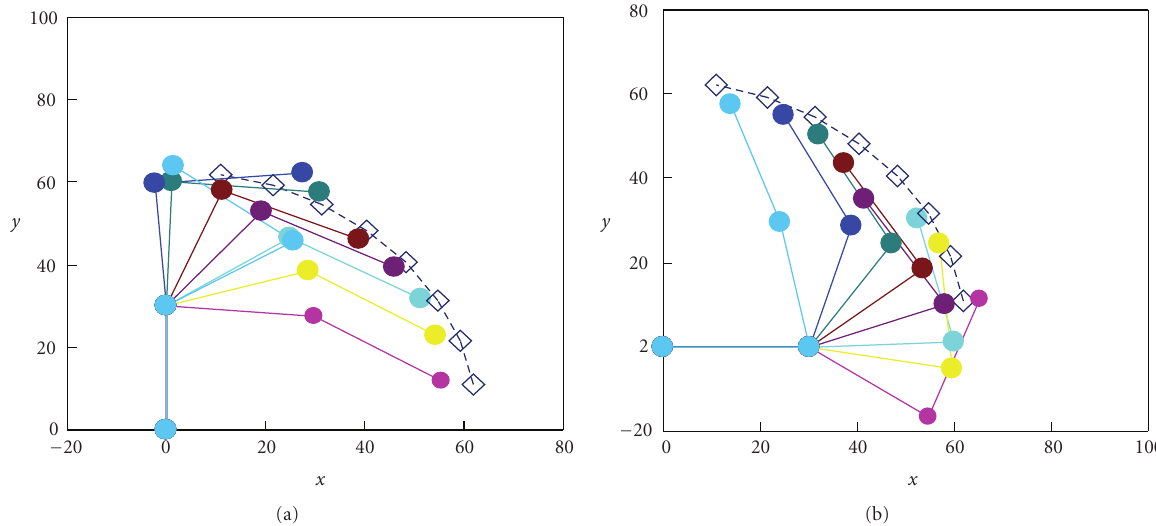
Figure 10: Graphs showing the coordinates of robot arm whose joint angles are estimated by network inversion with (a) regularization F 1 ( x ) and (b) regularization F 1 ( x ), for ill-posed problem with nonunique solution.